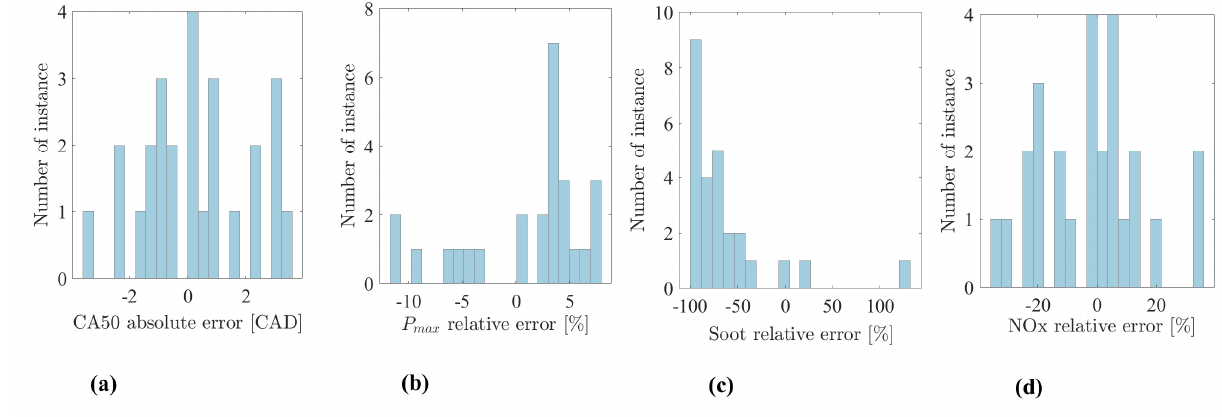
Figure 6. Histogram of error between physical–based model and experimental data. ( a ) CA50 absolute error [CAD], ( b ) Maxi- mum In-cylinder pressure ( P max ) relative error [%], ( c ) Soot emission relative error [%], ( d ) NOx emission relative error [%].